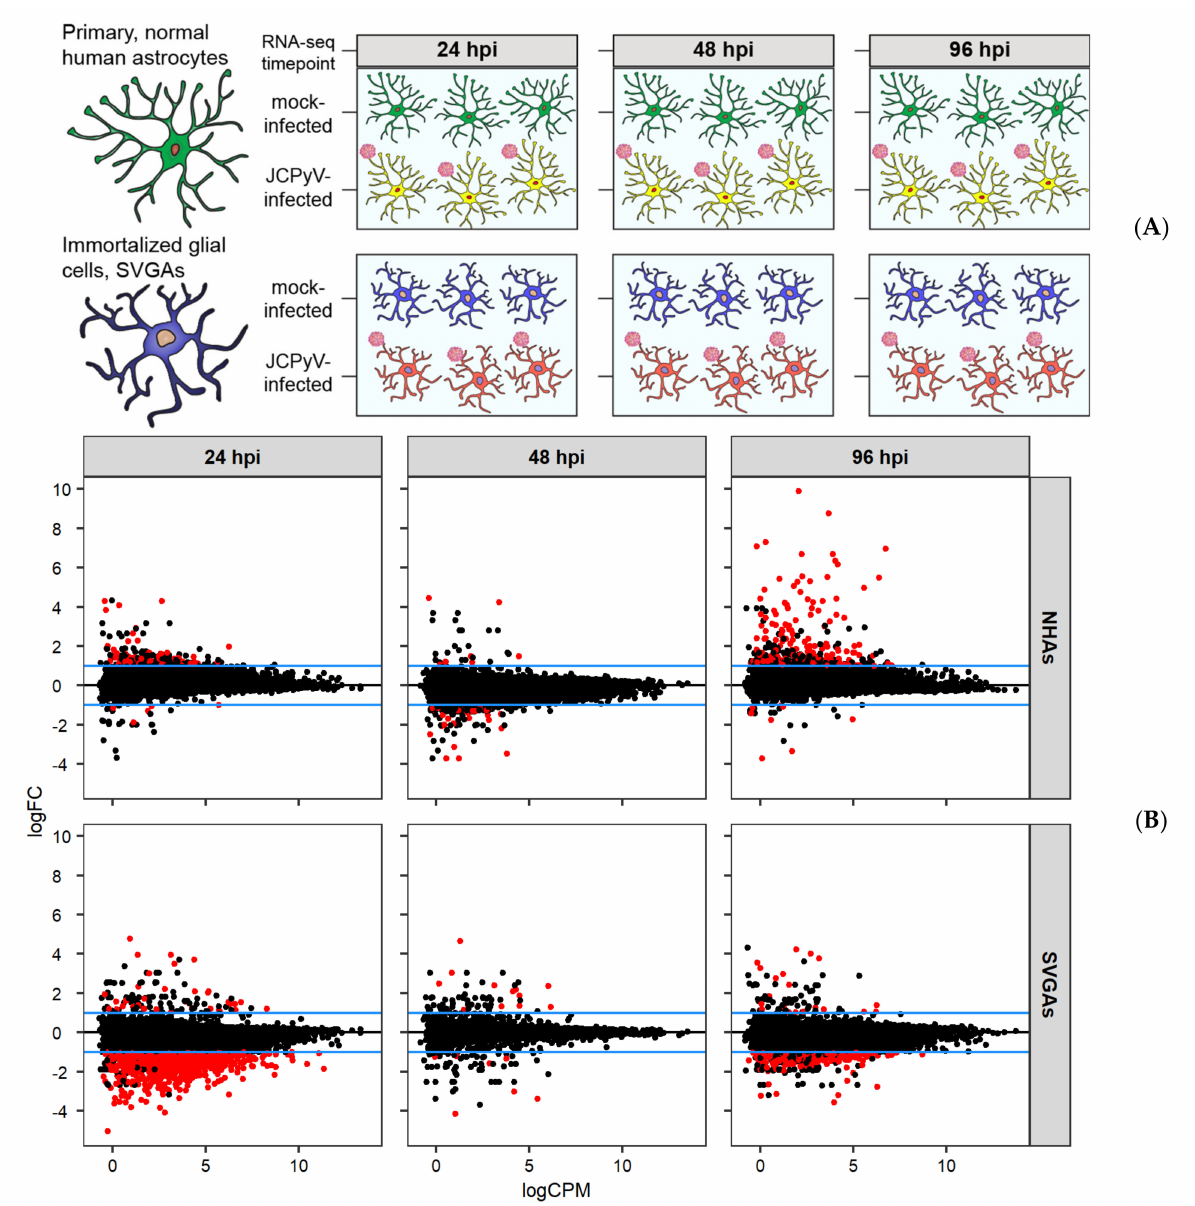
Figure 1. Whole transcriptome RNA-seq profiles of JCPyV infected primary astrocytes and SVGAs during course of infection reveal unique differential gene expression in primary cells. ( A ) Primary, normal human astrocytes (NHAs) and immortalized glial cells (SVGAs) were either infected with JCPyV (MOI = 0.1 FFU/cell) or mock-infected with a vehicle control, and the transcriptomic profile was determined at 24, 48, and 96 hpi. ( B ) RNA-seq data were normalized with the read CPM method and MA plots were generated from DEseq2 analysis at each timepoint representing the log 2 fold changes of JCPyV-infected NHAs versus mock-infected NHAs, or JCPyV-infected SVGAs versus mock-infected SVGAs. Black points are genes from the R/EdgeR analysis. Red points represent genes with a logFC greater or less than 1 and an unadjusted p value < 0.05. The blue lines in each plot represent the logFC = 1 and logFC = − 1; FC: Fold-change; CPM: Counts per